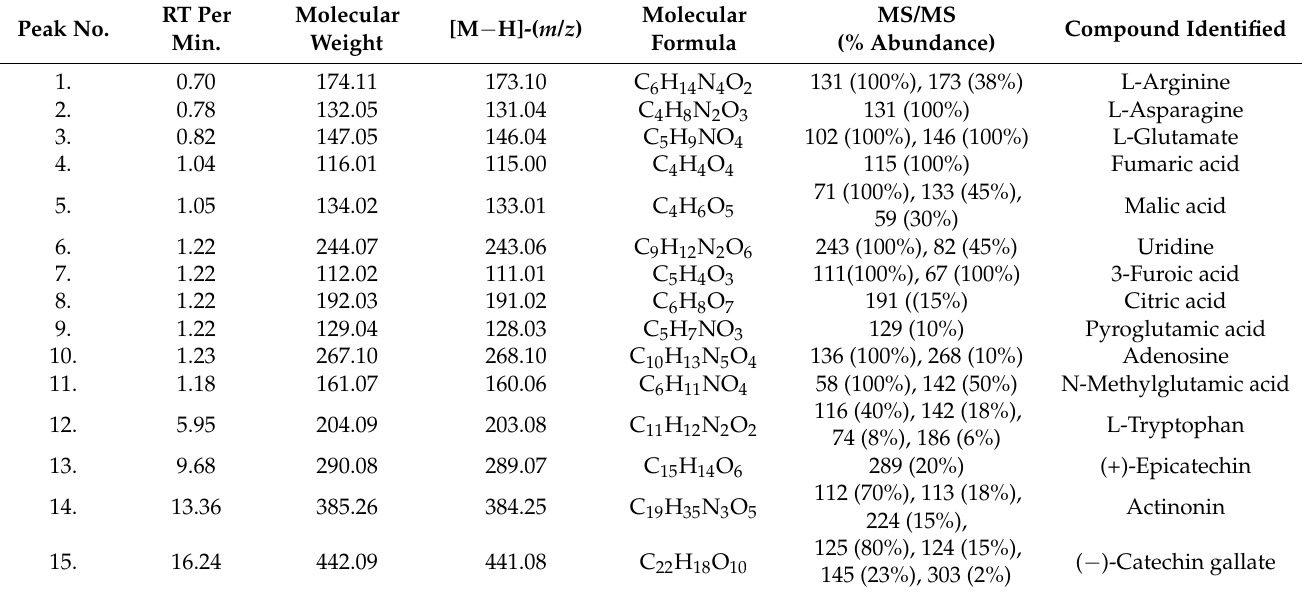
Table 1. Metabolites that were identified in the ethanol extracts of alfalfa and buckwheat seed extracts by UHPLC-Q-TOF- MS 2 . RT, retention time.